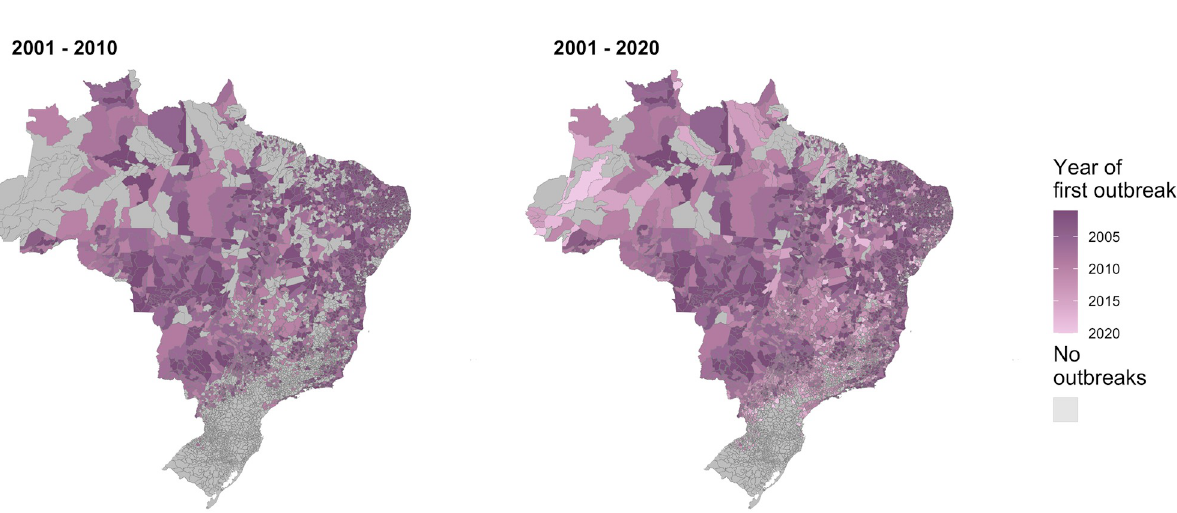
Fig 4. The first year each municipality experienced an outbreak for the first time in the period 2001–2010 and 2001–2020. The year each municipality first recorded over 300 cases per 100,000 residents. Recent data shows the previous barriers to dengue outbreaks in the Amazon and South are being eroded. Maps were produced in R using the geobr package [32,35](https://ipeagit.github.io/geobr/).